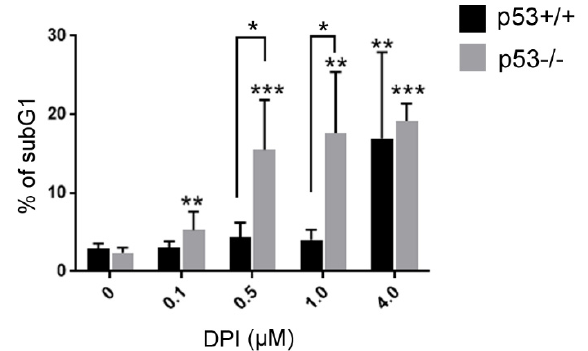
Figure 3. DPI-treatment induces DNA fragmentation preferentially in HCT116 p53 − / − cells. HCT116 cells were treated with different concentrations of DPI for 3 days and subsequently cultured in DPI-free medium for 3 days. SubG1 fraction was measured based on flow cytometry analysis of DNA content. Mean ± SD of the percentage of cells in the subG1 fraction, measured in at least 3 independent experiments, is presented, * p < 0.05, ** p ≤ 0.01; *** p ≤ 0.001.